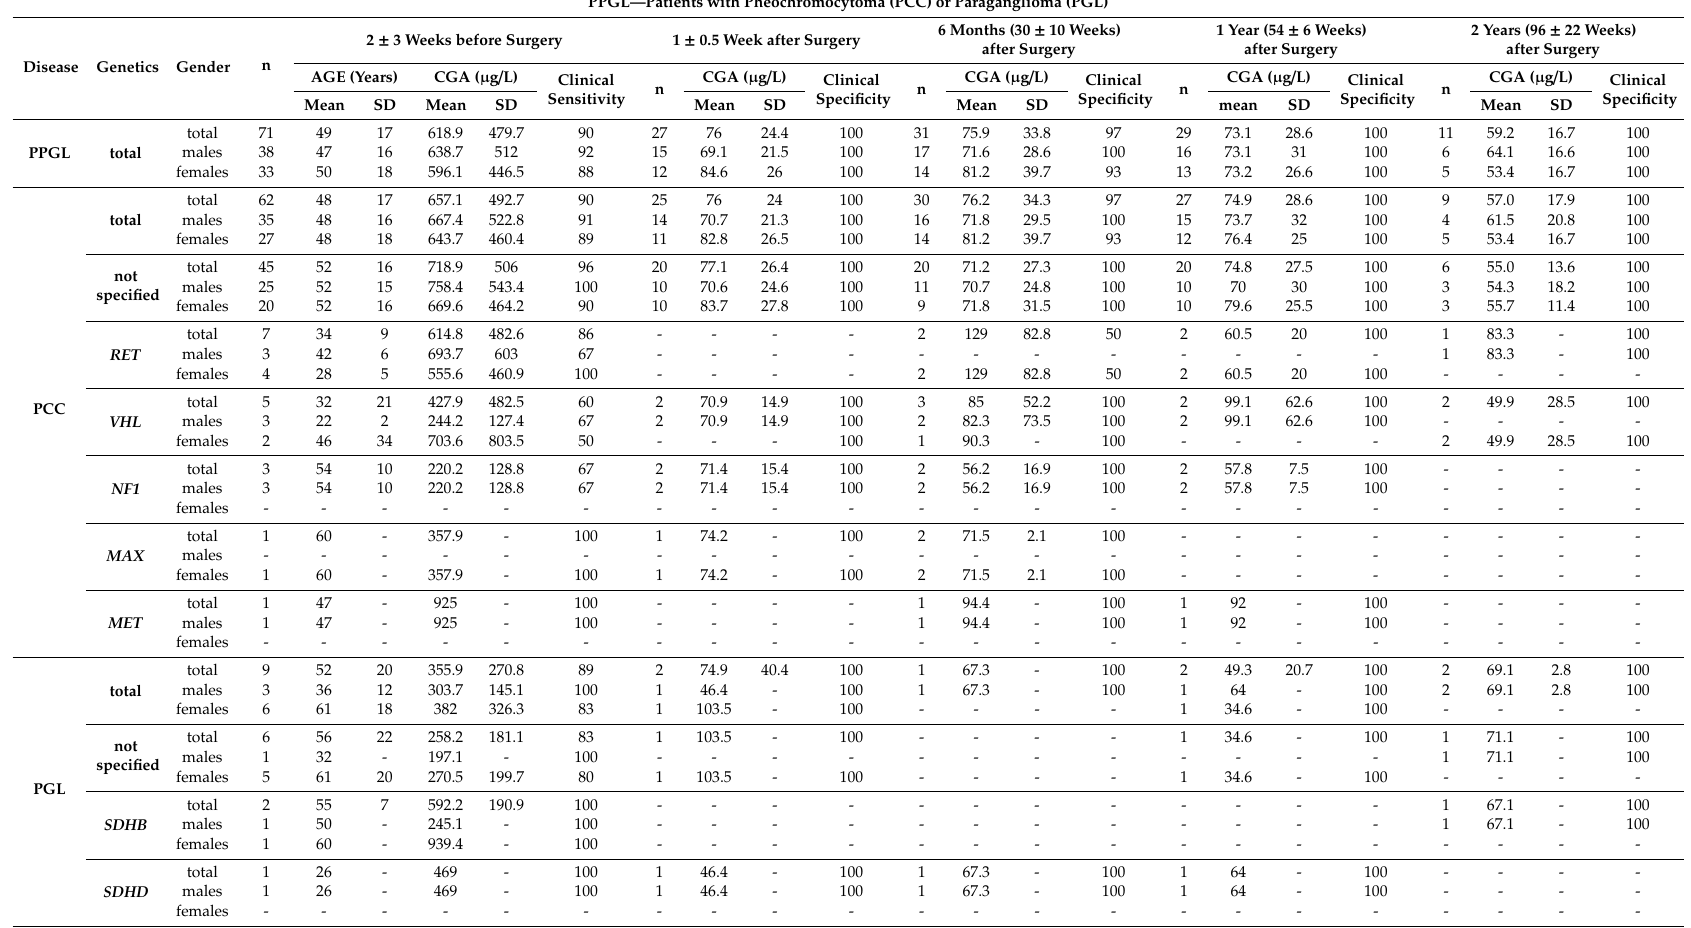
Table 1. The clinical sensitivity and specificity of PPGL patients based on the plasma chromogranin A (CGA) determinations before and after the adrenal surgery. The meaning of abbreviations is pheochromocytoma (PCC); paraganglioma (PGL); together denoted as PPGL; mutations in genes RET ; VHL ; NF1 ; MAX ; MET ; SDHB and SDHD ; number (n); standard deviation